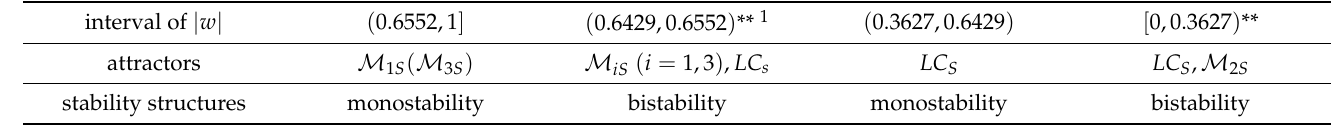
Table 1. Attractors and the corresponding intervals of the slow variable w